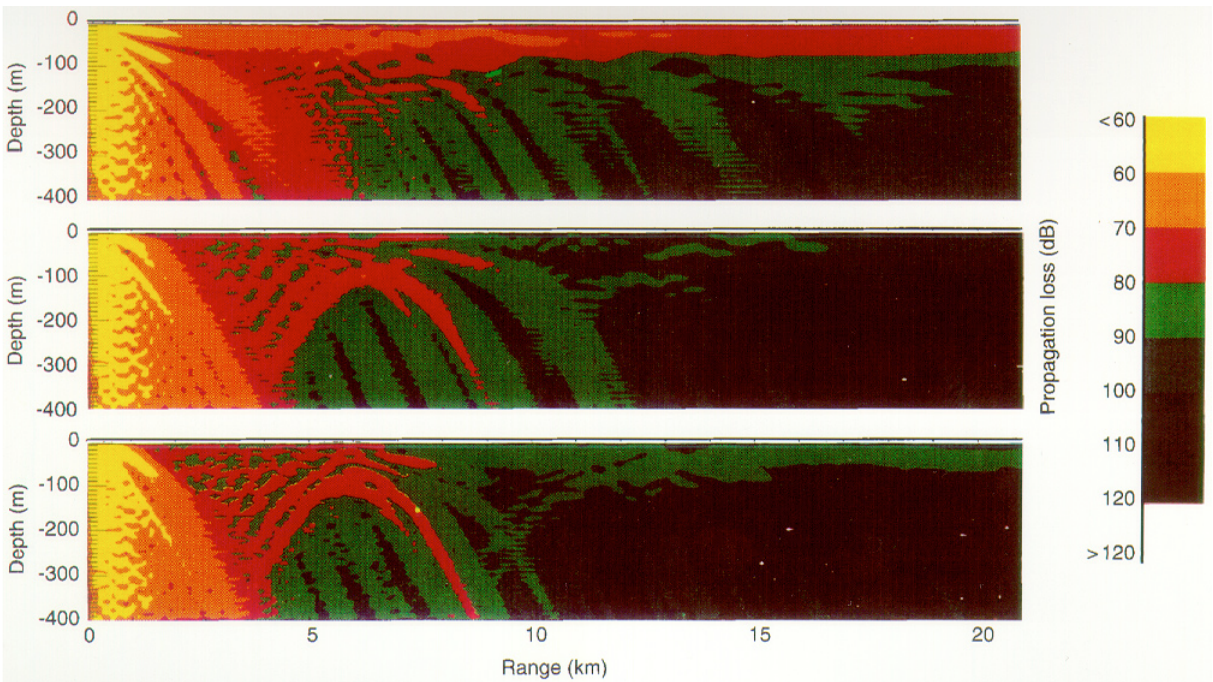
Fig. 10. Propagation-loss contours through the eddy environment, frequency 400 Hz, source depth 50 m. „ op panel range-independent background, middle panel feature model, bottom panel observed case